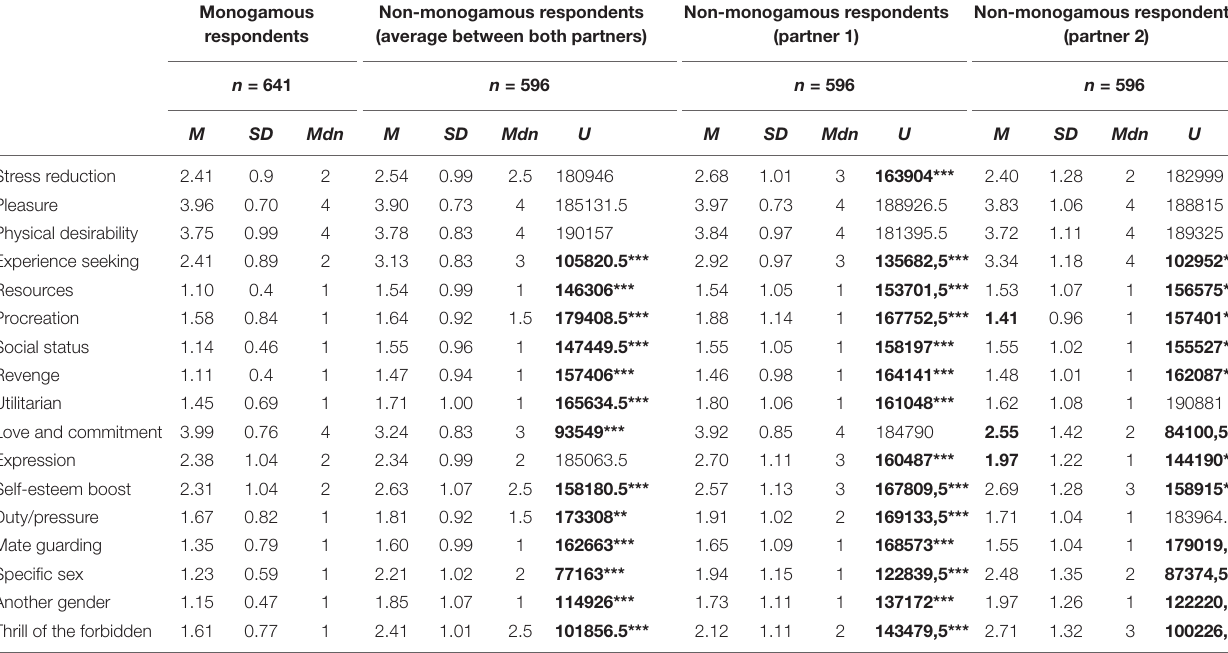
TABLE 1 | Reasons to engage in sex among monogamous and non-monogamous